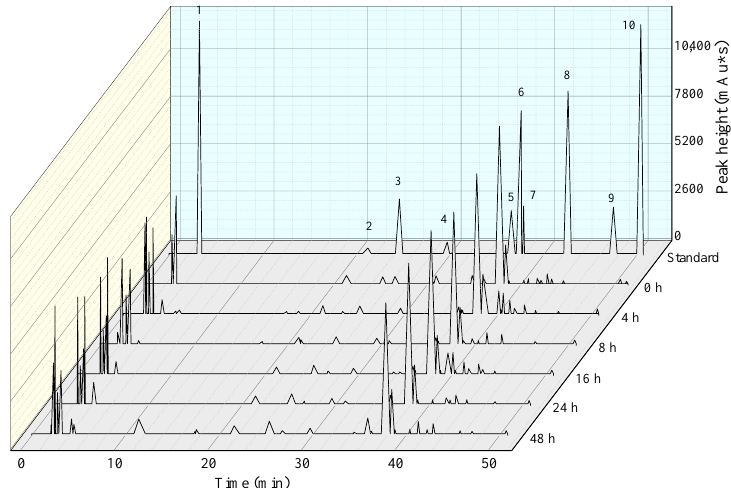
Figure 7. Chromatograms of polyphenolic profiles in 200 MPa treated apple juice with different